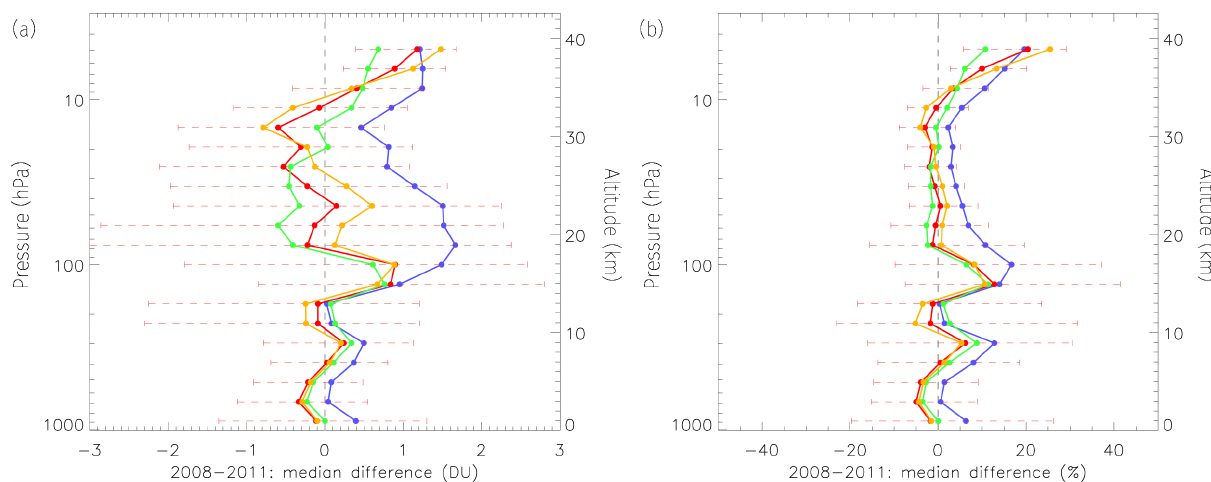
Figure 13. Validation of the model runs with ozone sondes for 2008–2011. (a) The median of the absolute difference in DU, (b) the median of the relative differences. Blue: model run without assimilation, green: model run with assimilation of GOME-2 only, yellow: run with assimilation of OMI only, red: assimilation of both GOME-2 and OMI. The error bars are plotted for the simultaneous assimilation only, and range from the 25 to the 75% percentile.